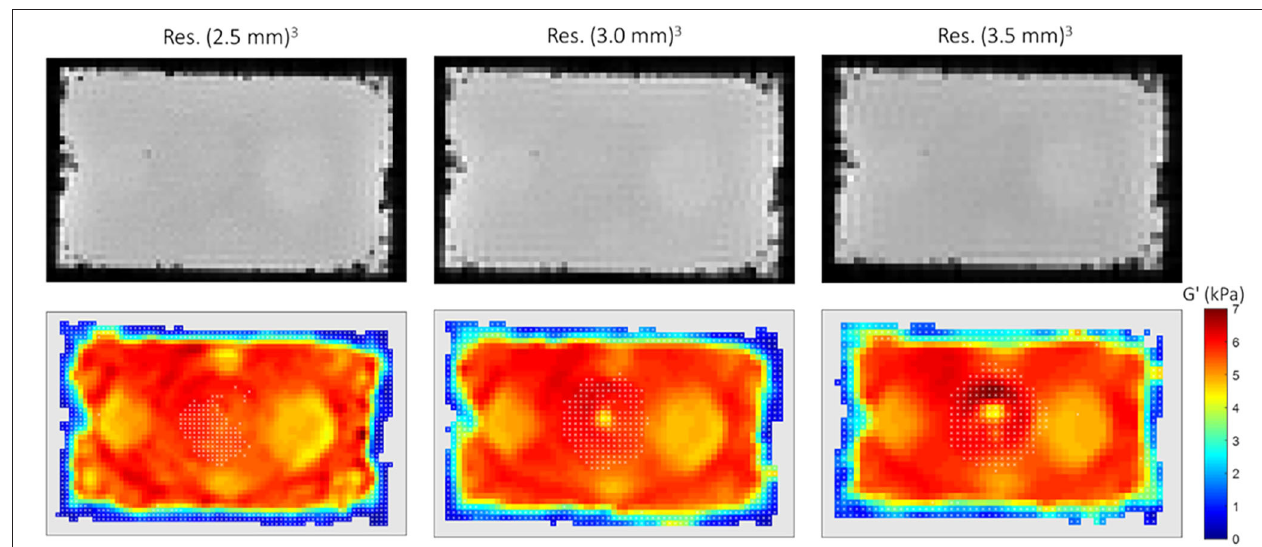
FIGURE 5 | MRE results at week 4 post fabrication for different resolutions (from left to right: (2.5mm) 3 , (3.0mm) 3 , (3.5mm) 3 ). Top row: magnitude of the reference dataset in the 5th slice. Bottom row: corresponding G’ maps with phantom’s contours being masked (light gray) and white cross hatches indicating the voxels discarded based on the SNR